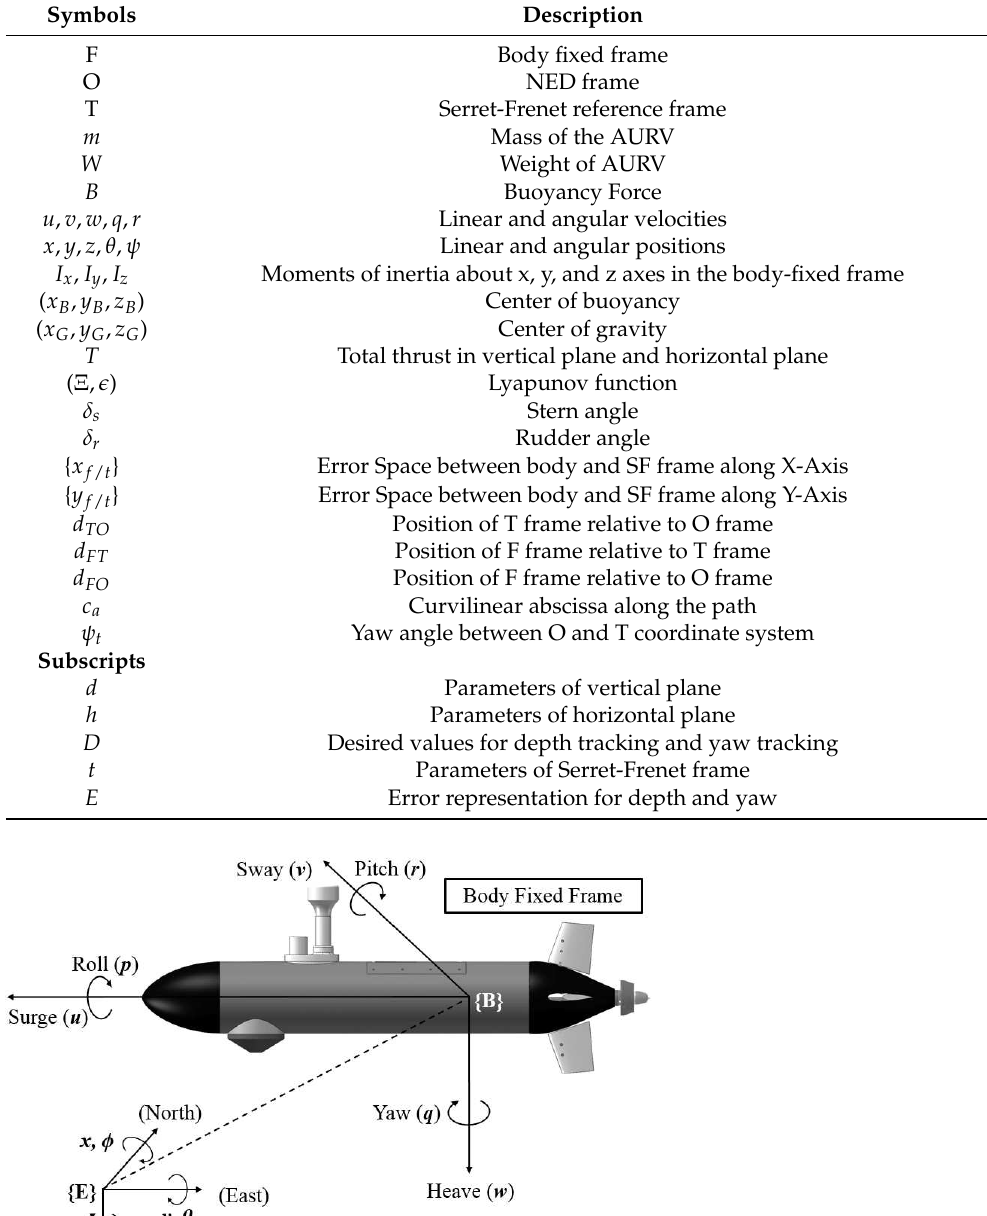
Table 1. Nomenclature.